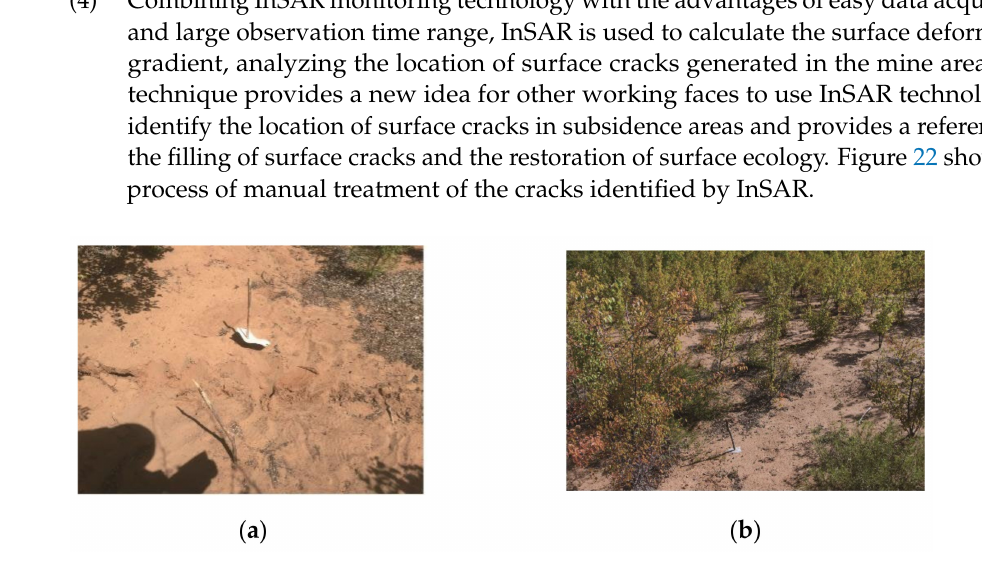
Figure 22. Crack manual management process: ( a ) Filled cracks; ( b ) Ecological